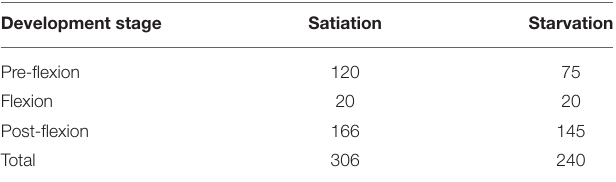
TABLE 1 | Number of Sparus aurata larvae tested along ontogeny under satiation and starvation